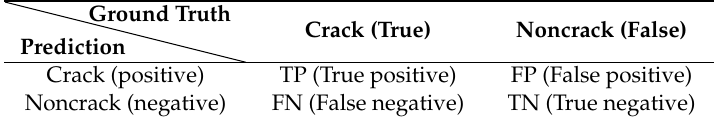
Table 3. Four identification statuses for each pixel of the input crack sub-image. PredictionGround Truth Crack